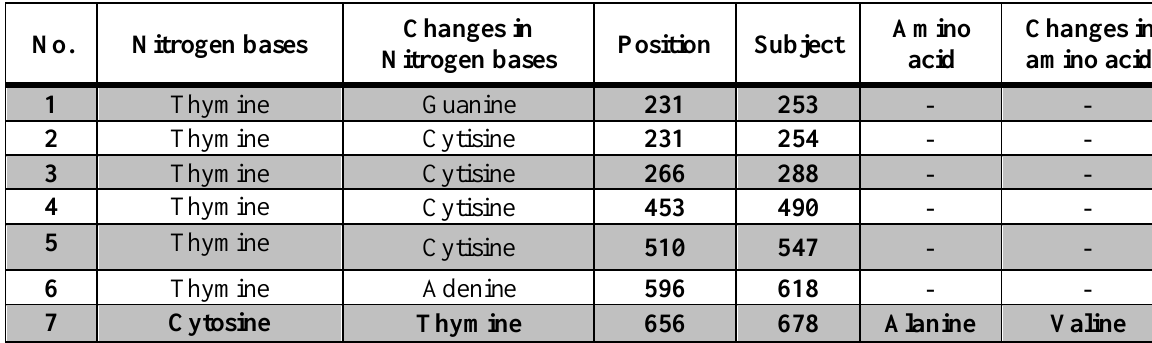
Table (4): Changes in nitrogen bases and their effect on amino acid translation in the